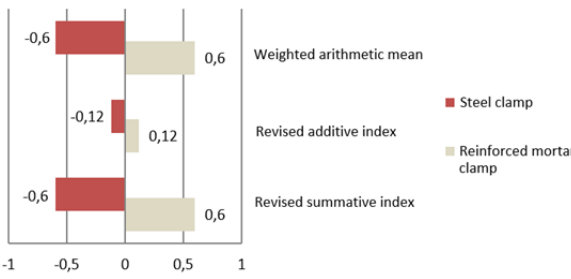
Figure 2: Comparison of synthetic measure values for standariza-